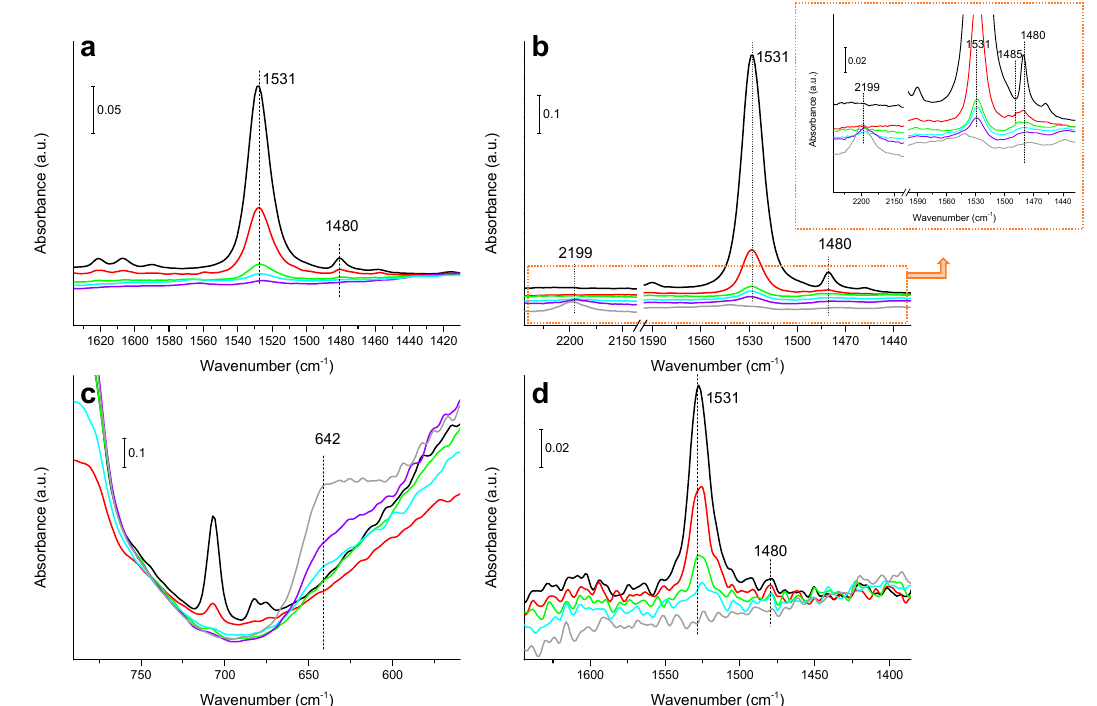
Figure 3. IR spectra of nitrobenzene adsorbed on: ( a ) Cu 0.5 Pd/SiO 2 , ( b ) Cu 2 Pd/SiO 2 (in the inset a zoom of the bottom part of the IR spectra), ( c ) Cu 2 Pd/SiO 2 in the low frequency region, ( d ) Cu 2 Ni/SiO 2 and their evolution at increasing temperatures: 25 °C (black), 60 °C (red), 120 °C (green), 140 °C (cyan), 180 °C (violet) and 200 °C (grey).